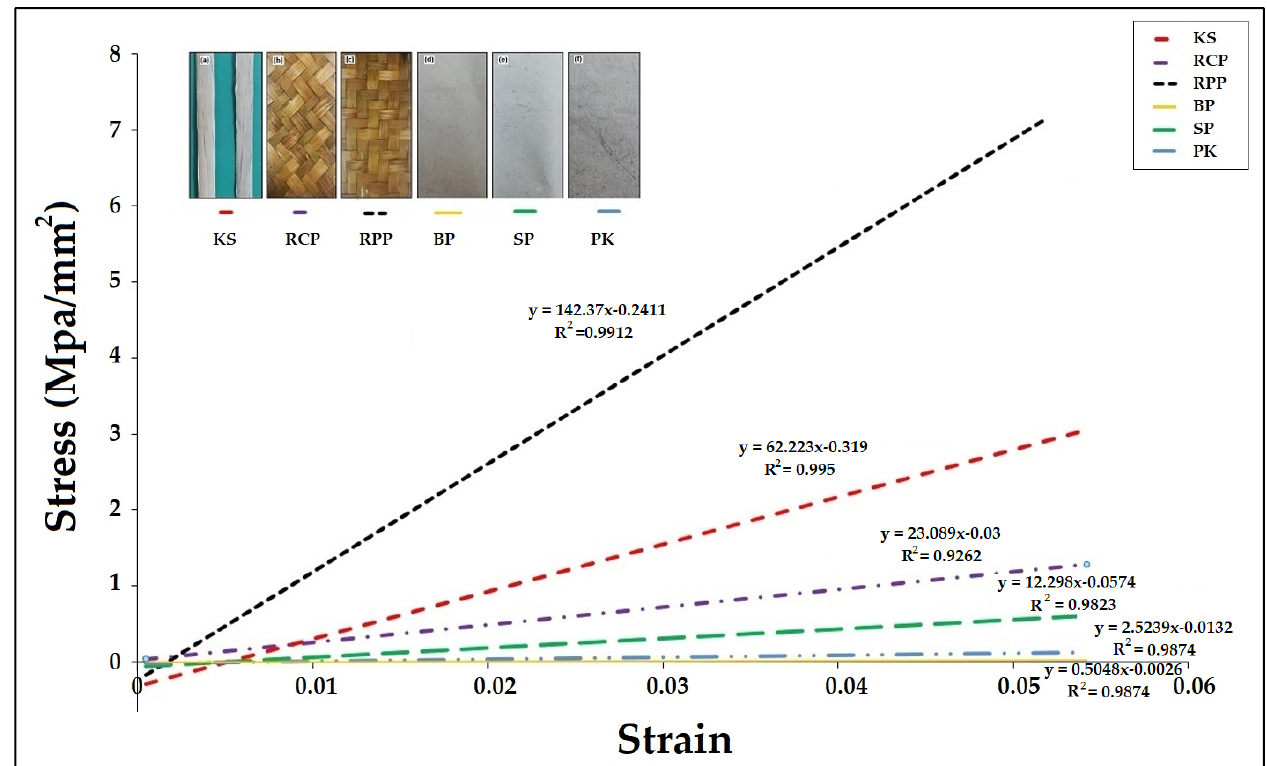
Figure 2. Comparison of Young’s modulus for Krajood strips (KS), residue of cross weave pattern (RCP), residue of plain weave pattern (RPP), bag made of paper (BP), shirt backing paper (SP) and paper made from Krajood (PK).